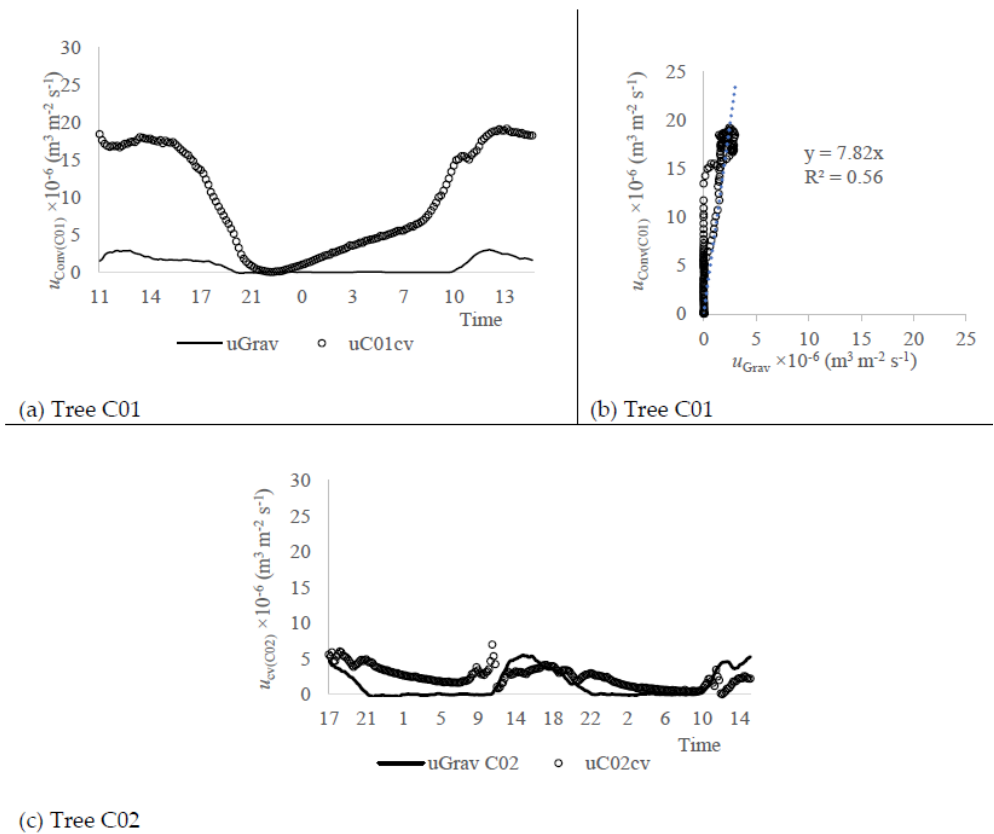
Figure 7. Sap flux density computed with the conventional Granier approach ( u cv , m 3 m − 3 s − 1 ) and that obtained with the gravimetric test ( u Grav , m 3 m − 3 s − 1 ) on the sensor (Experiment I): ( a ) C01, circadian curves (17–18 April 2018); ( b ) C01, regression curve u Grav versus u cv ; ( c ) C02, circadian curves (18–20